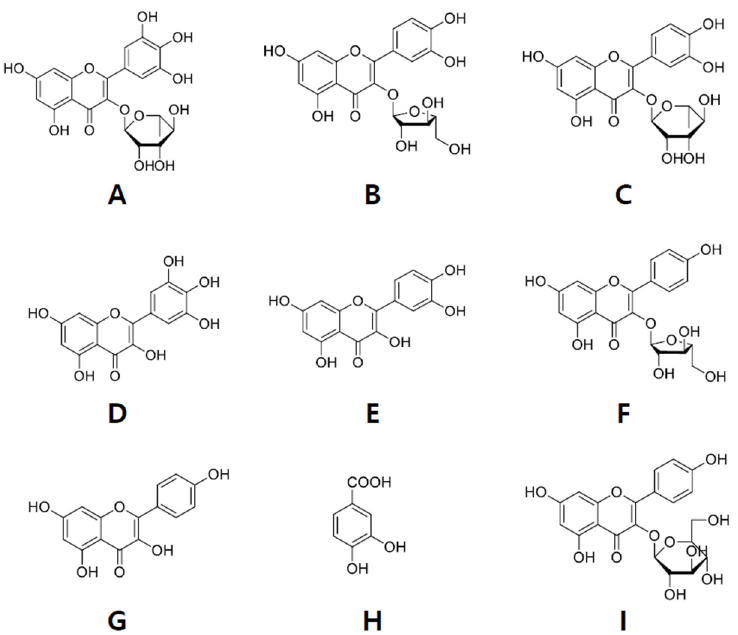
Figure 1. Chemical structure of compounds isolated from Polygonum aviculare L. ( A ) Myricetin-3-O- rhamnoside; ( B ) Quercetin-3-O-arabinofuranoside; ( C ) Quercetin-3-O-rhamnoside; ( D ) Myricetin; ( E ) Quercetin; ( F ) Kaempferol-3-O-arabinofuranoside; ( G ) Kaempferol; ( H ) Protocatechuic acid; ( I ) Kaempferol-3-O- β -D-glucopyranoside.